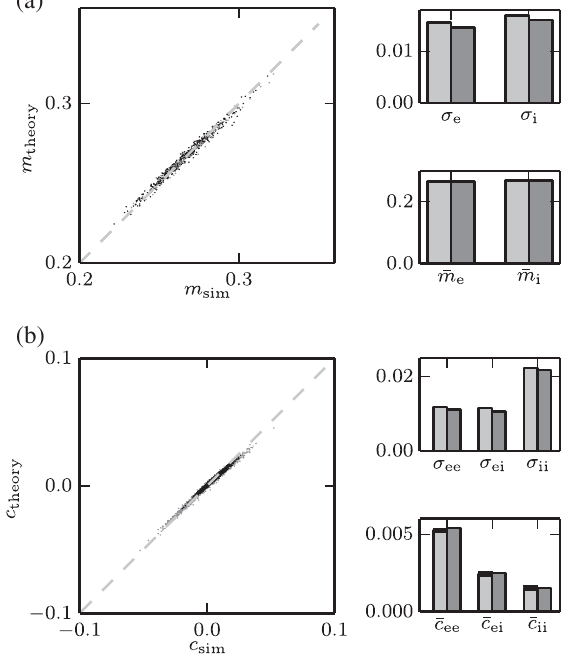
FIG. 4. Approximation for covariance matrix in a random network of binary neurons including third-order cumulants. (a) Theoretical prediction of mean activities (25) versus simu- lation results (black is for excitatory; gray is for inhibitory). Lower inset: Mean activity averaged over excitatory and inhibi- tory neurons (light gray is for simulation; darker gray is for theory). Black error bars (not visible, below line width) show the standard error of the mean obtained from 20 simulations. Upper inset: Standard deviation of distribution of mean activities of excitatory ( σ e ) and inhibitory ( σ i ) neurons. (b) Theoretical prediction (26) versus simulated covariance (black is for ex- citation-excitation; gray is for inhibition-inhibition; light gray is for excitation-inhibition). Lower inset: Mean covariances aver- aged over excitatory-excitatory, excitatory-inhibitory, and over inhibitory-inhibitory neuron pairs (light gray is for simulation; darker gray is for theory). Error bars show the standard error of the mean obtained from 20 simulations. Upper inset: Standard deviations of the distributions of covariances. Network param- eters and the display are the same as in Fig. 1. Theoretical predictions are obtained by damped fixed-point